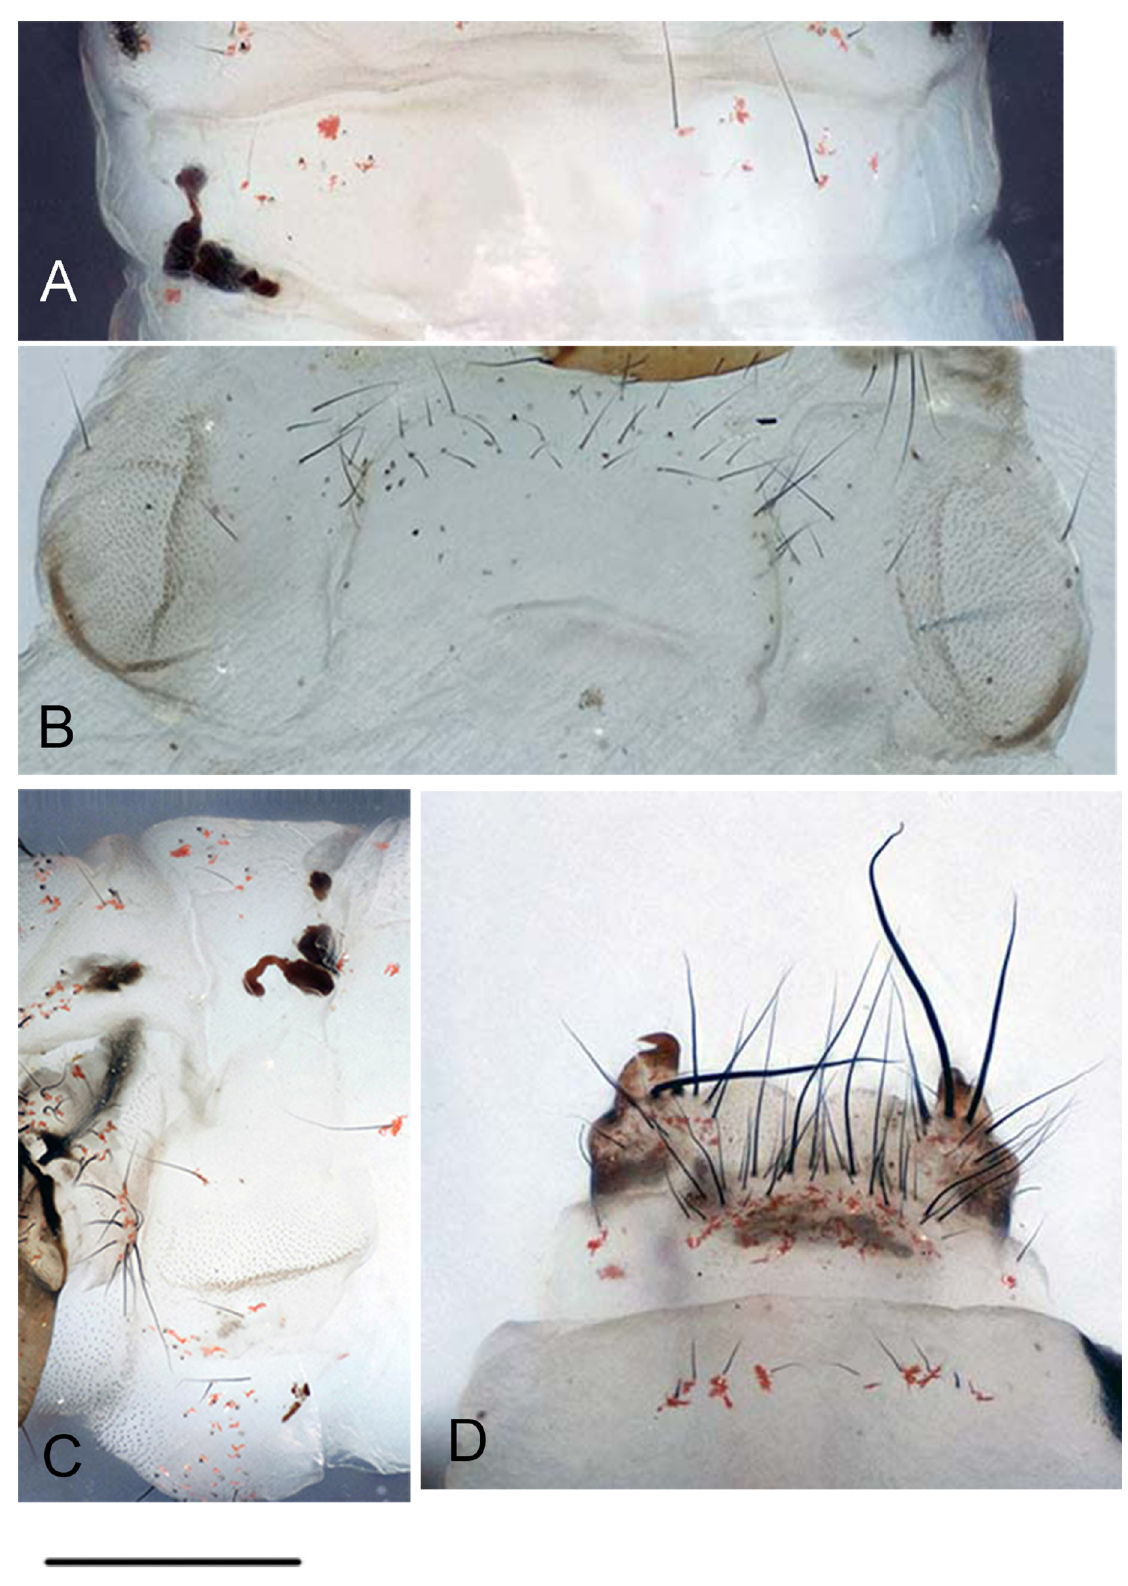
Fig. 12. Abdomen of Apatidelia acuminata Leng & Yang, 1998, larva. A–C . Segment I. A . Dorsal view. B . Ventral view. C . Lateral view. D . Segments IX–X and anal claw (dorsal view). Scale bar = 0.5